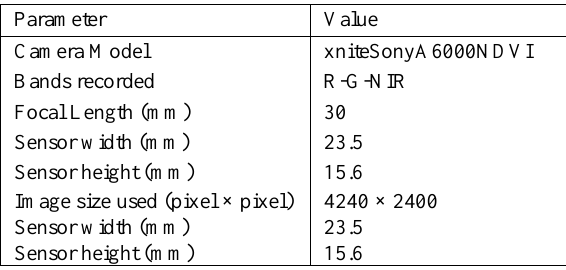
Similarly, trees were categorized as per crown area. The study area was largely dominated by trees with crown area of 60-80m 2 . crown areas of all trees was found to be 74.49 m².